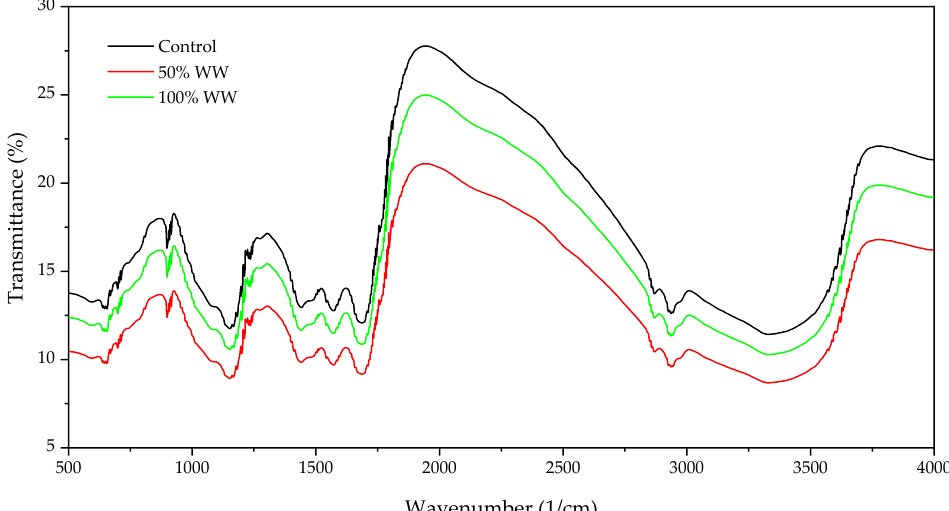
Figure 5. EDX graphs for ultimate element analysis (C, O and N) of C. vulgaris biomass cultivated in different concentrations of mushroom farm wastewater (WW: wastewater).